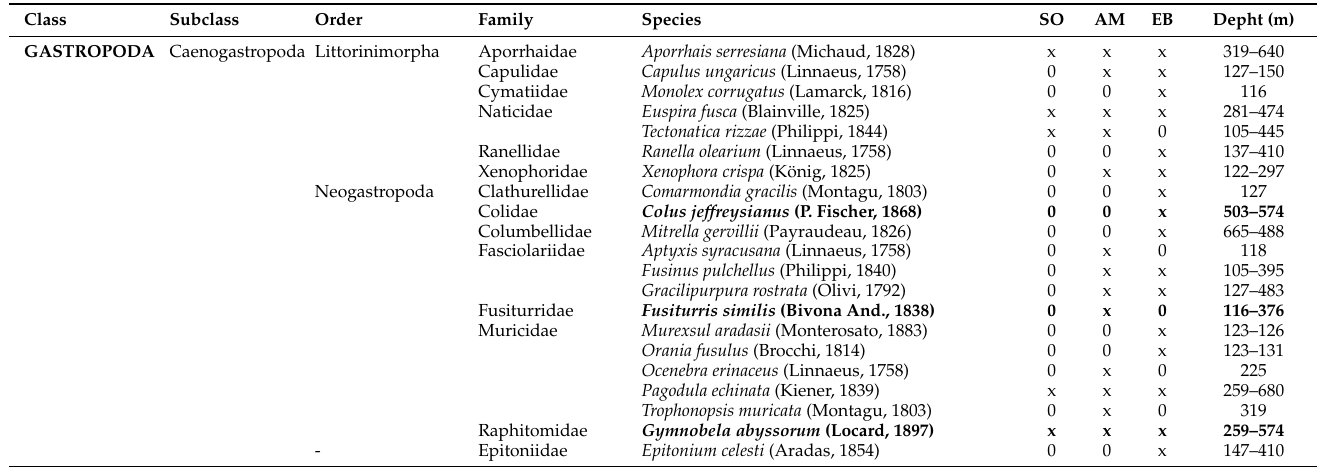
Table 2. List of live collected molluscs specimens in the Mallorca Channel (Balearic Islands, western Mediterranean) seamounts: Ses Olives (SO), Ausias March (AM) and Emile Baudot (EB). Information on the presence (x) and no presence (0) of the species by seamount is also provided. New records shown in